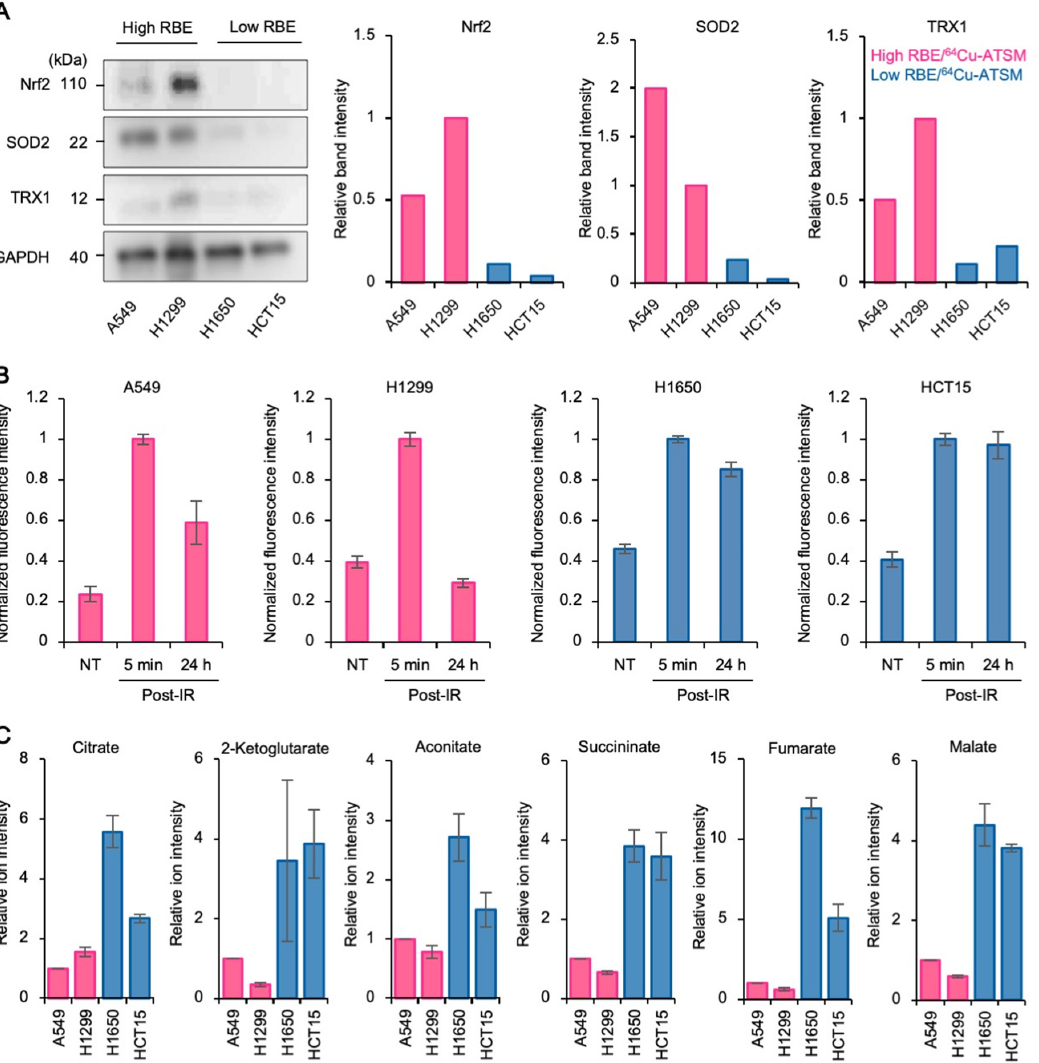
Figure 3. Upregulation of antioxidant systems plays a role in high RBE/ 64 Cu-ATSM uptake. ( A ) Greater expression of antioxidant proteins in high RBE/ 64 Cu-ATSM cells than in low RBE/ 64 Cu-ATSM cells under steady-state conditions, as assessed by immunoblot analysis. Bar graphs show quantitated band intensities, normalized according to GAPDH. ( B ) High RBE/ 64 Cu-ATSM cells show greater ROS scavenging capacity in response to X-ray irradiation than low RBE/ 64 Cu-ATSM cells. Cells were treated with X-rays (4 Gy) and assessed using the Cellular ROS Assay (Abcam). For each cell line, DCF fluorescence signals, as measured by flow cytometry, are shown after normalizing to those obtained 5 min post-irradiation (mean ± SD; n = 3). ( C ) Downregulation of TCA cycle intermediates in high RBE/ 64 Cu-ATSM uptake cells compared to low RBE/ 64 Cu-ATSM uptake cells, as assessed by LC-MS/MS (mean ± SD; n = 3). To further consolidate the above findings, we investigated the effect of Nrf2 inhibi- tion on sensitivity to X-rays or carbon ions since Nrf2 is a major regulator of cellular anti- oxidant activity [38]. Brusatol, an Nrf2 inhibitor, efficiently suppressed the expression of